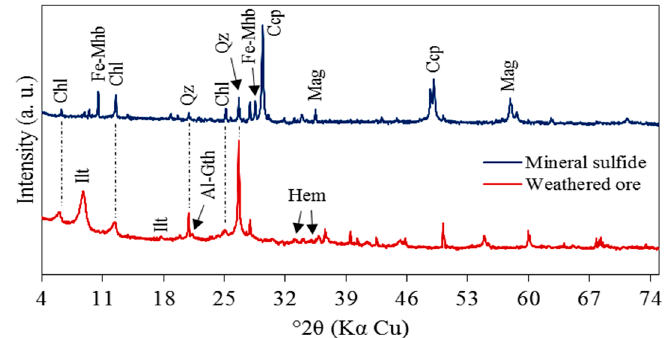
Figure 3. X-ray diffraction (XRD) diffractograms of mineral sulfide (blue line) and weathered ore (red line) samples. Chl: chlorite; Fe-Mhb: ferrous magnesiohornblende; Ccp: chalcopyrite; Mag: magnetite; Ilt: Illite; Al-Gth: aluminous goethite; e Hem: hematite.